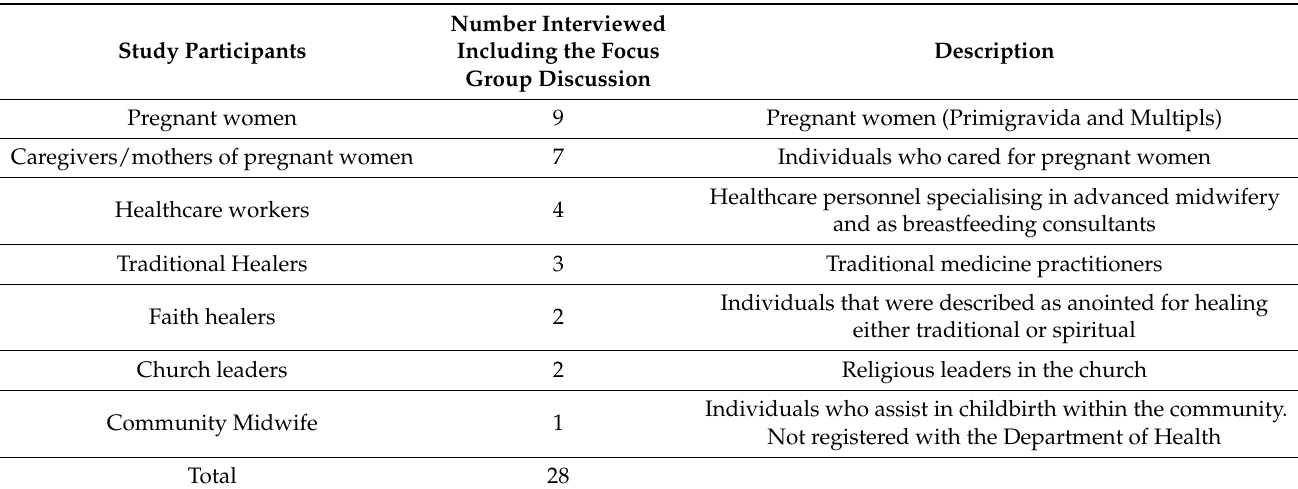
Table 1. Study participant